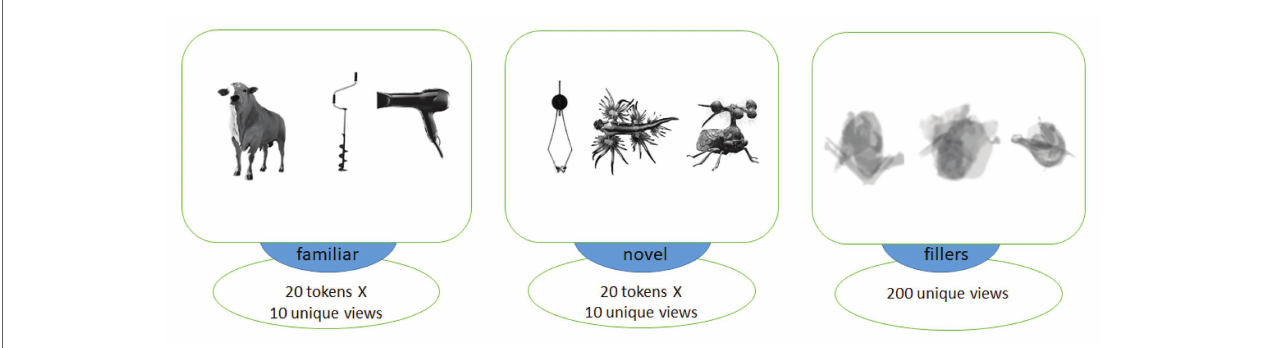
FIGURE 1 | Examples of images of objects used in association with familiar (left) and novel (middle) words as well as visually matched filler items (right) . Each trial included two images from different categories, with filler images used in the explicit encoding (EE) condition only to balance it visually against the fast mapping (FM)